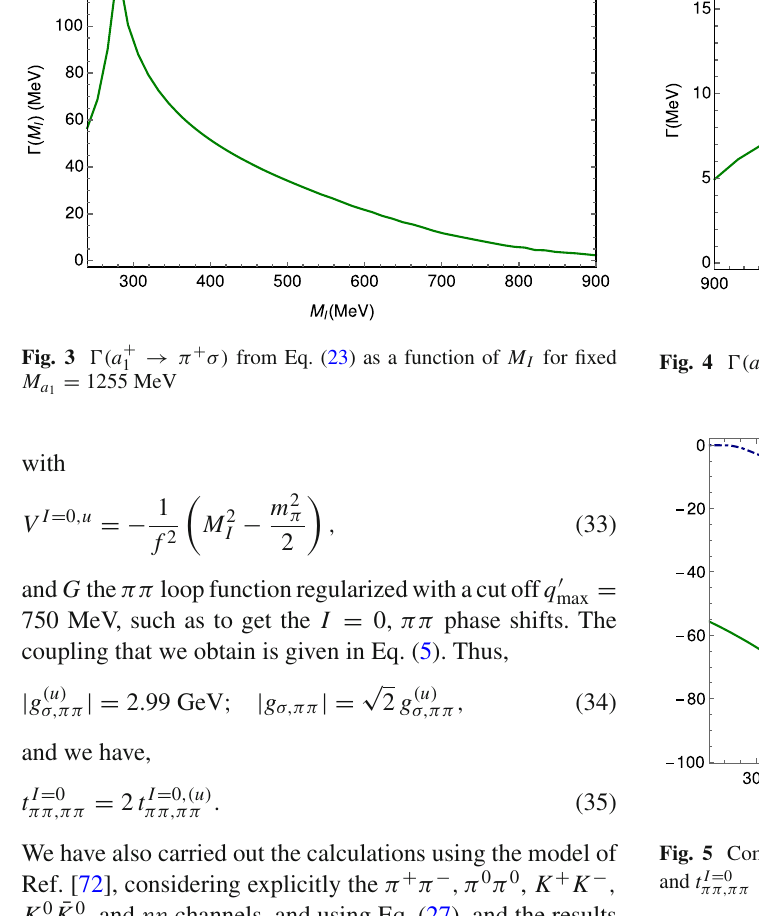
versus that of the realistic t I = 0 ππ,ππ amplitude, Im t I = 0 ππ,ππ .